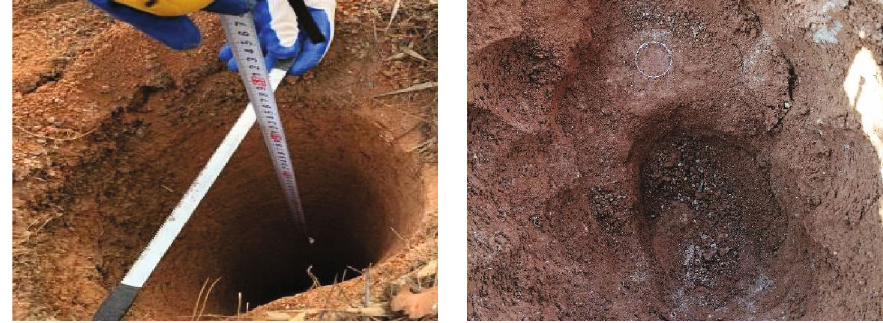
Figure 1: Sampling site of ore soil at di ff erent